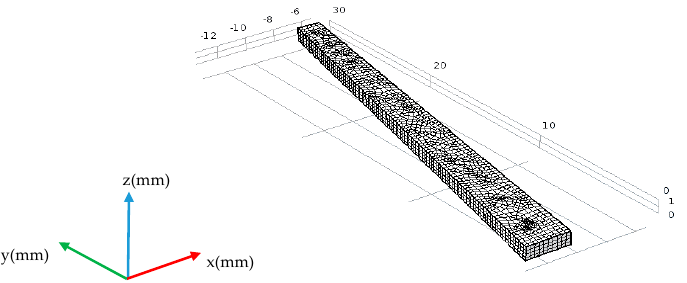
Figure 4. Frequency-domain-analysis simulation model of array element.